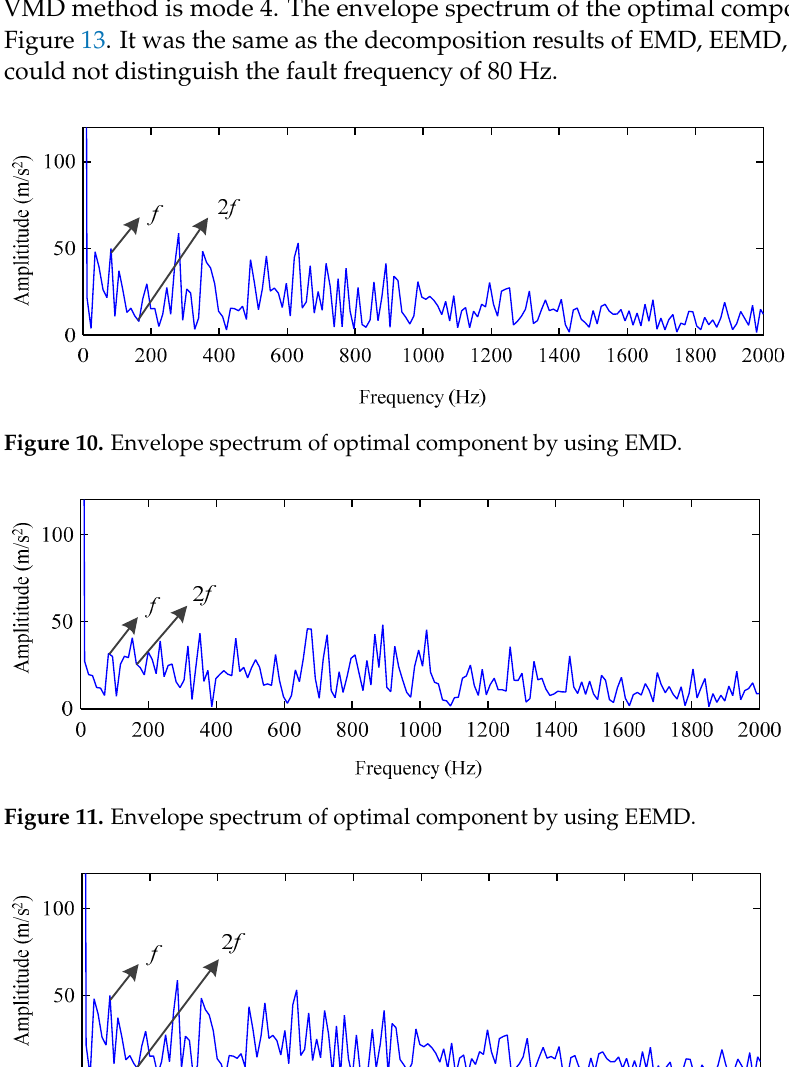
Figure 9. Residues of added white noises derived by EEMD and CEEMD.